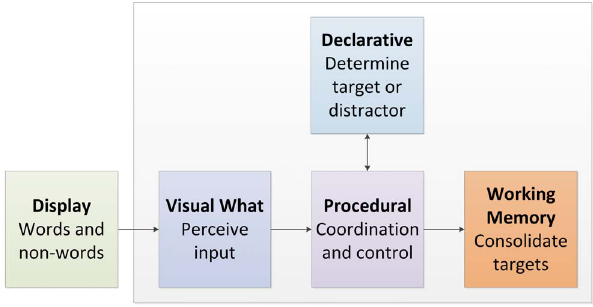
Figure 3. An overview of the modules and their role in the TC AB